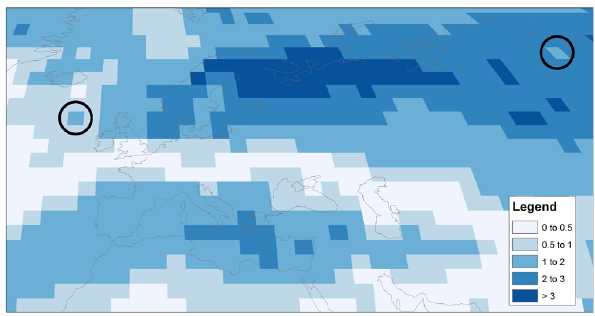
Fig. 5. Simultaneous contrast illusion means that the grid cell cir- cled on the right hand side does not appear the same colour as the one on the left. Also the grid cell on the right does not match the legend (even though they are both in the 1–2